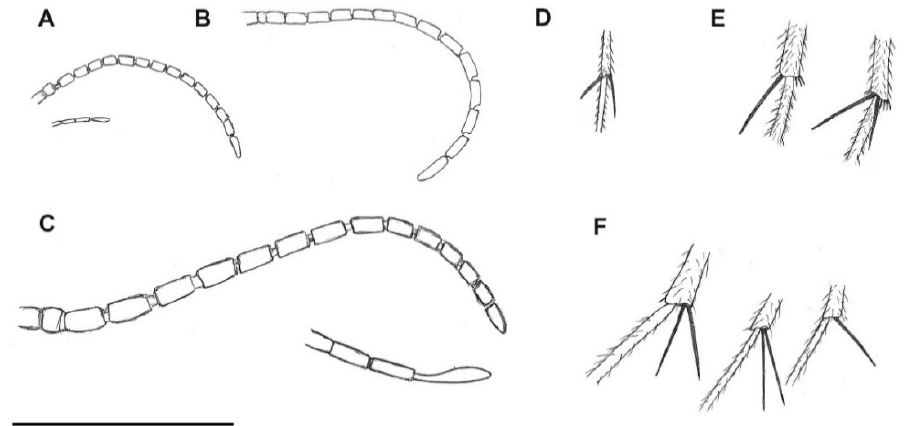
Figure 4. Paleoplatyura agnieszkae sp. nov., antenna ( A ) and middle leg ( D ); P. miae sp. nov., antenna ( B ); hind and middle leg ( E ); P. magnifica sp. nov., antenna ( C ), hind, middle, and foreleg ( F ). Scale bar = 1 mm.